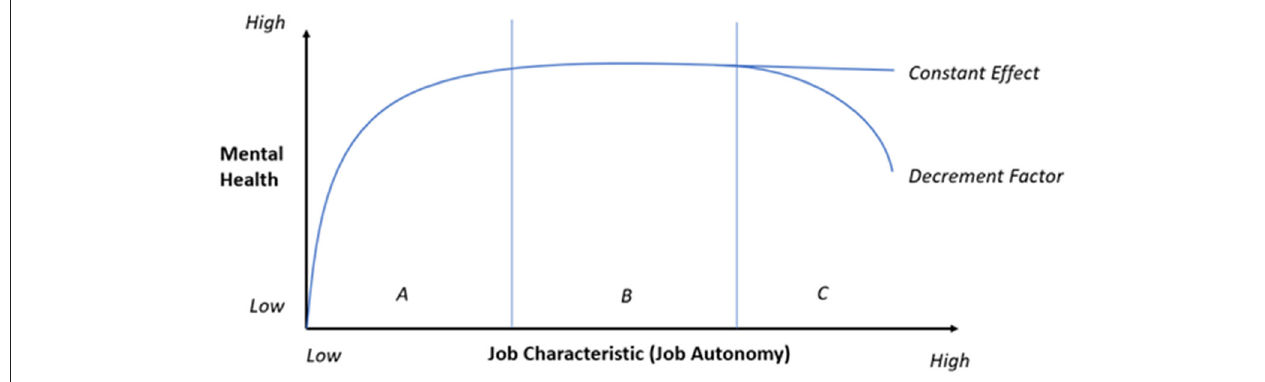
FIGURE 3 | Vitamin-Model. Positive effect of increasing autonomy (A) , plateau (B) and additional decrement (C)